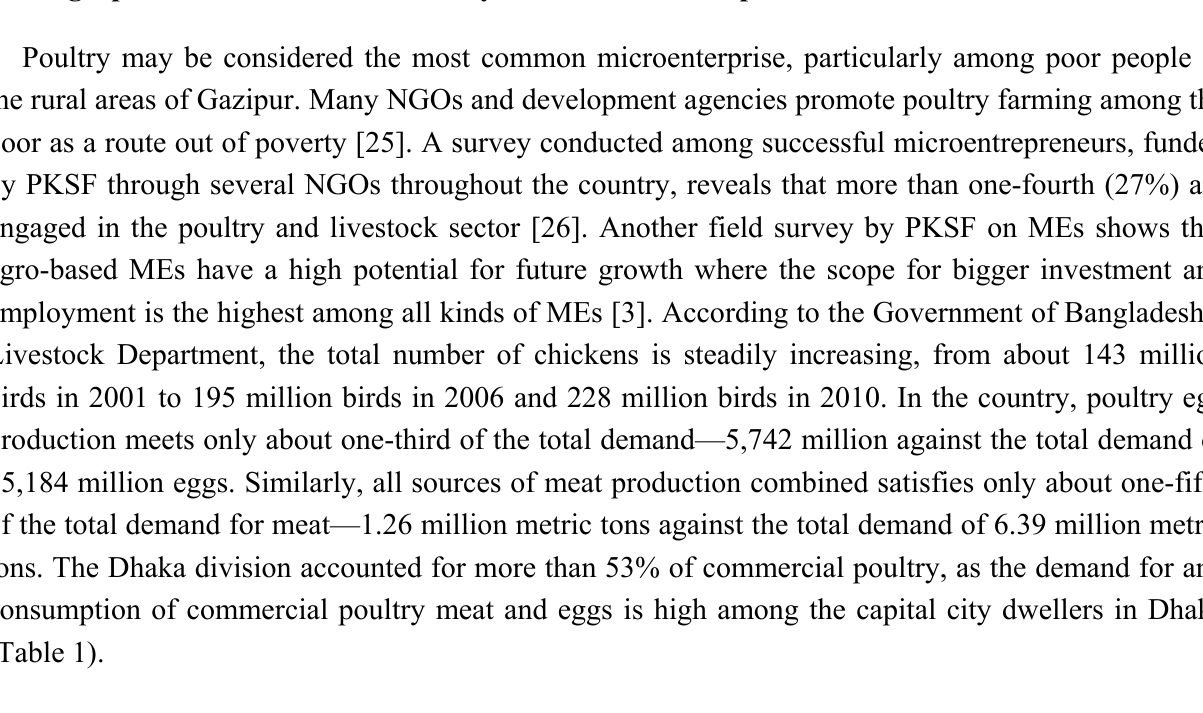
Table 1. Distribution of poultry by divisions of Bangladesh and districts of Dhaka